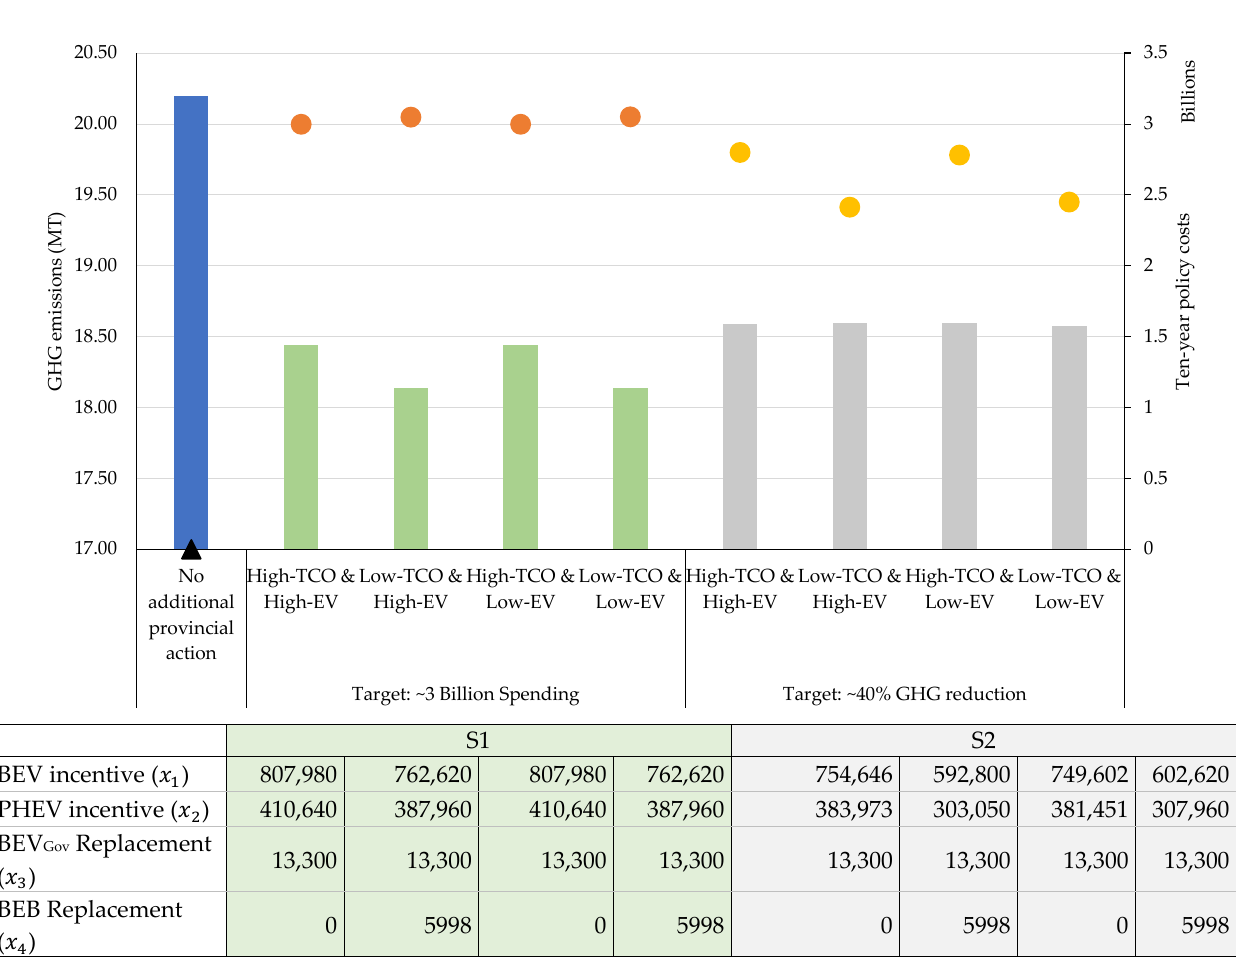
Figure 2. The optimized ten-year costs, savings, and allocation of GHG reduction policies ( X 1 , X 2 , X 3 , and X 4 ) for two discrete scenarios. The scenarios demonstrate upper- and lower- bound costs as a result of total cost of ownership (TCO) and EV sales associated. The first scenario S1 (green) represents a target of $3 billion in spending over ten years and the resulting policy allocation and GHG reduction. The second scenario S2 (grey) represents a target of 40% GHG reduction in year 2030 and the resulting ten-year policy allocation and costs. The points on the graph correspond to the secondary y-axis in which the first scenario is represented by orange points and the second scenario is represented by yellow points.